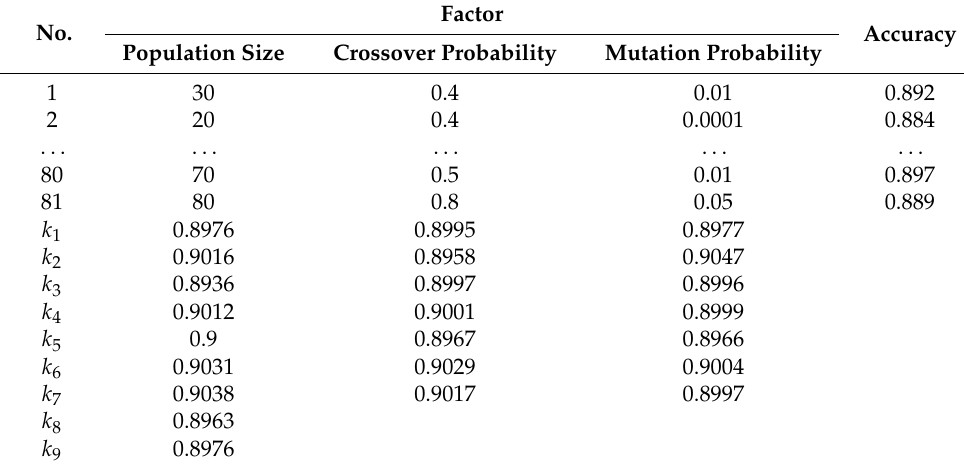
Table 2. Orthogonal table L81 (9 × 72) design for GA parameter settings and experimental results.